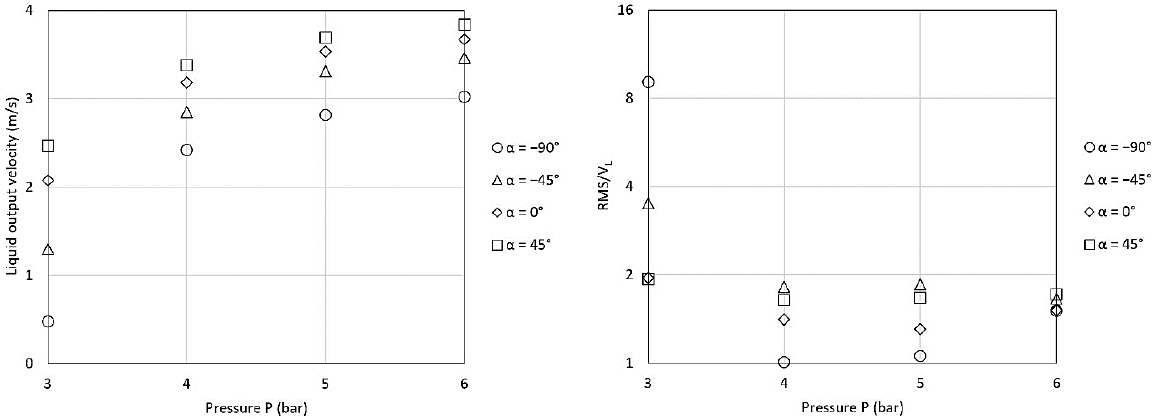
Figure 8. Distribution of liquid output velocity and normalized RMS for the tested nozzle operating parameters.